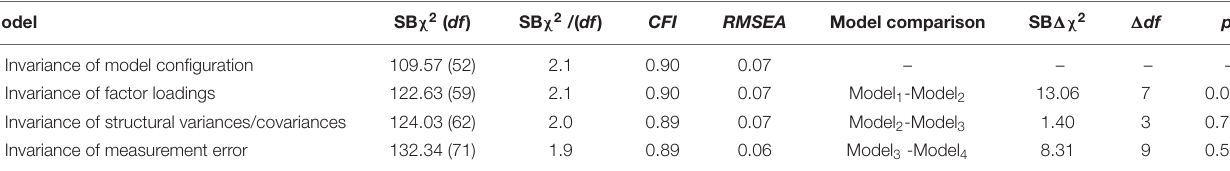
FIGURE 3 | (A) Bayesian independent samples t- test for the effect size δ . The probability wheel on top visualizes the evidence that the data provide for the null hypothesis (H0: effect sizes are equal) and the alternative hypothesis (auburn, H1: effect sizes are different). The median and the 95% central credible interval of the posterior distribution are shown in the top right corner. (B) The Bayes factor robustness plot. The plot indicates the Bayes factor BF01 (in favor of the null hypothesis) for the default prior ( r = 0.707), a wide prior ( r = 1), and an ultrawide prior ( r = 1.414). TABLE 5 | Goodness-of-fit statistics for each level of structural and measurement invariance across languages. Model SB χ 2 ( df ) SB χ 2 /( df ) CFI RMSEA Model comparison SB (cid:49) χ 2